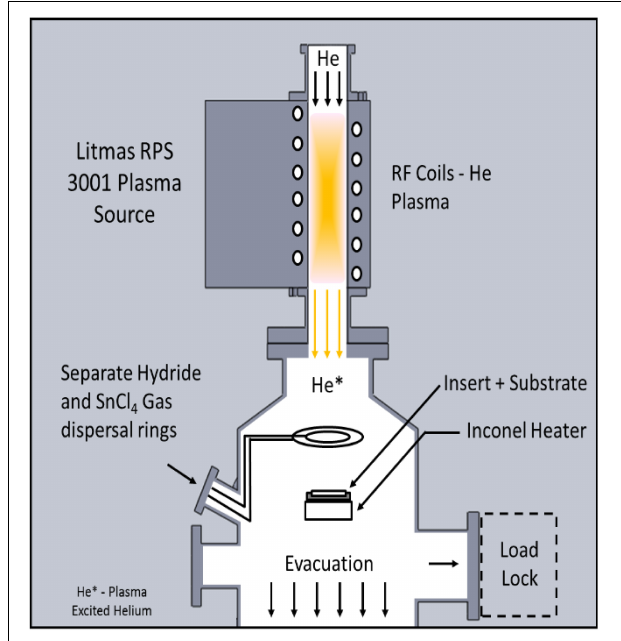
FIGURE 1 | Equipment configuration of RPECVD growth